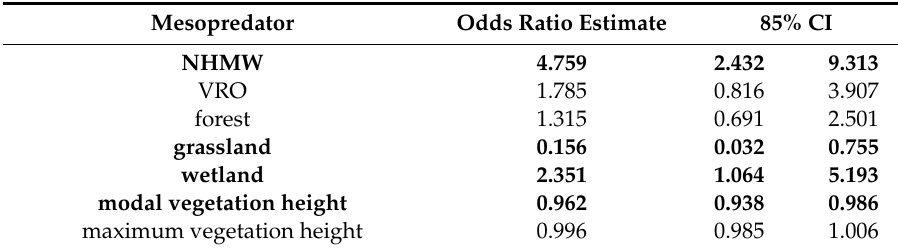
Table 2. Odds ratio estimates with 85% confidence intervals (CI) for predicting if predator groups (mesopredator or rodent) interacted with three-dimensional printed turtle models depending on numerous explanatory variables: study site (Nettie Hart Memorial Woods [NHMW] and Vermilion River Observatory [VRO] in relation to Fort Custer Training Center), habitat type (forest, grassland, and wetland in relation to forest edge), modal and maximum height (cm) of vegetation around models, distance (cm) from a model to woody structure, whether models were visually exposed in relation to concealed, whether models did not have turtle scent on them in relation to scented models, or the interaction of exposure and scent treatments.